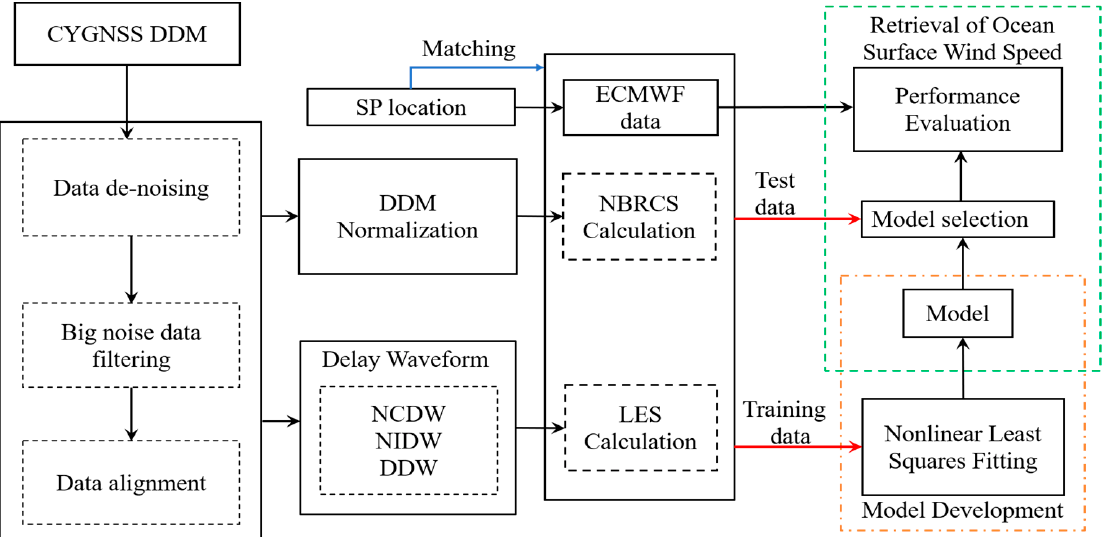
Figure 1. Flow chart of wind speed estimation model construction. The first stage is data preprocessing. The second stage is data matching. The third stage is the model development process (marked in the orange box) and the model selection and performance evaluation (marked in the green box).